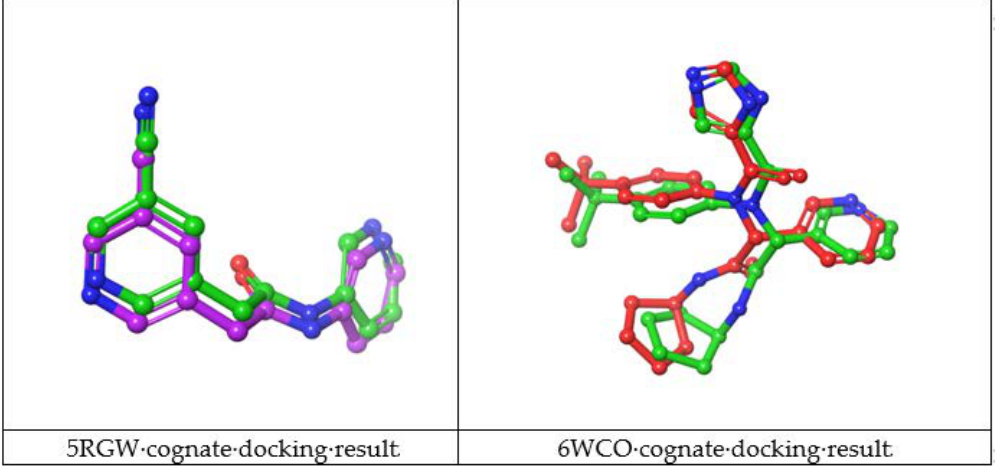
Figure 2. Superimposition of the docked 5RGW (purple), 6WCO (orange) and the crystallographic (green) conformations of the cognate ligands binding pose.